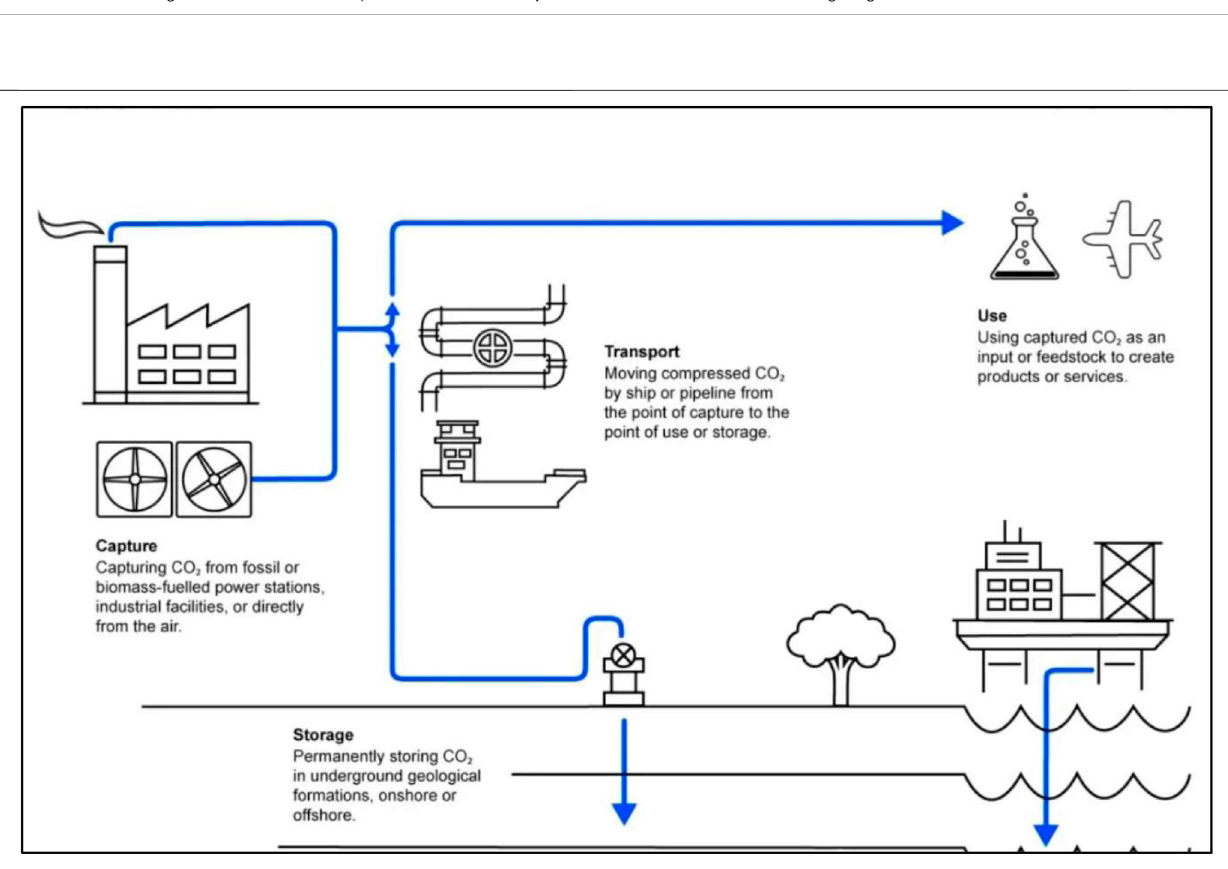
FIGURE 1 | CCUS fl ow